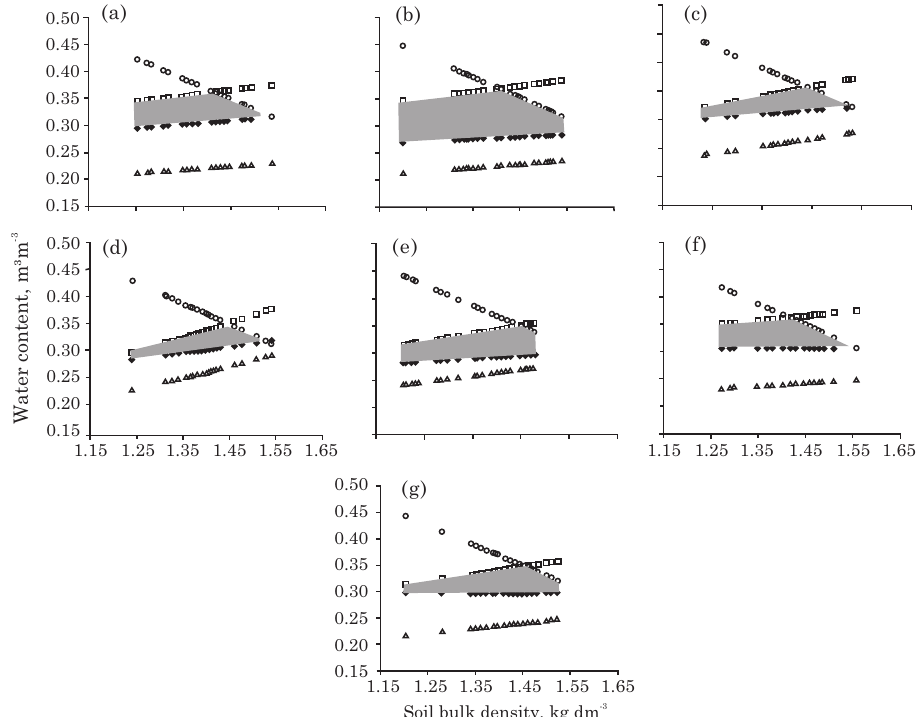
Figure 4. Least limiting water range in soil under winter crops [(a) corn, (b) sunflower, (c) oilseed radish, (d) pearl millet, (e) pigeon pea, (f) grain sorghum, and (g) sunn hemp] within corn/corn in summer in which o = air-filled porosity, oo oo o = field capacity, = soil resistance to penetration, and ∆∆∆∆ ∆ = permanent wilting